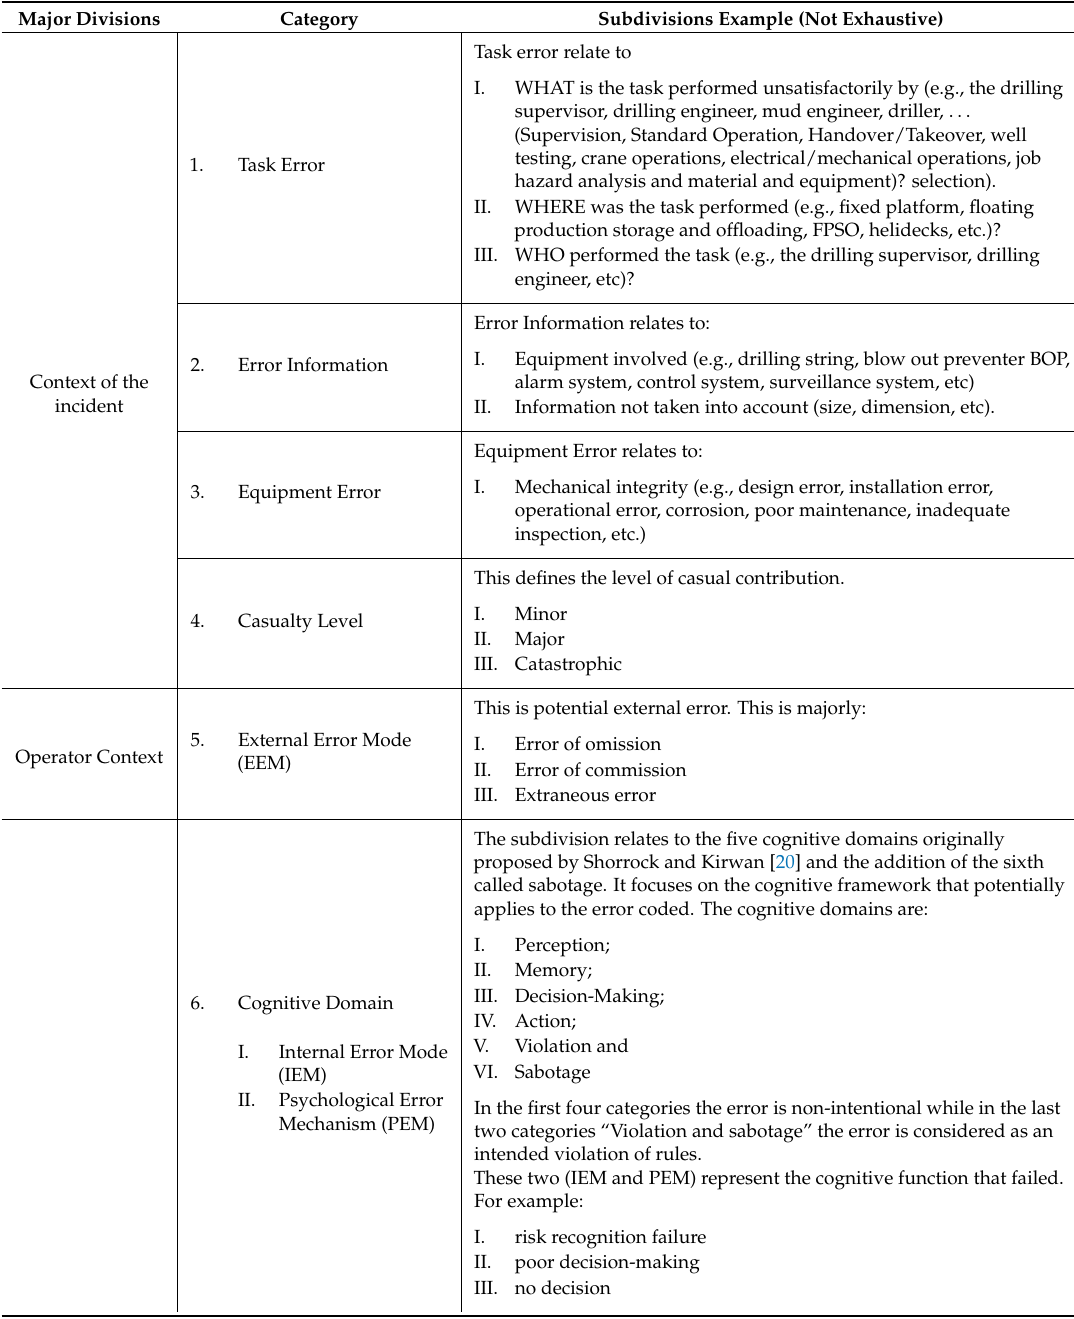
Table 4. Levels and subdivisions of TRACEr-OGI